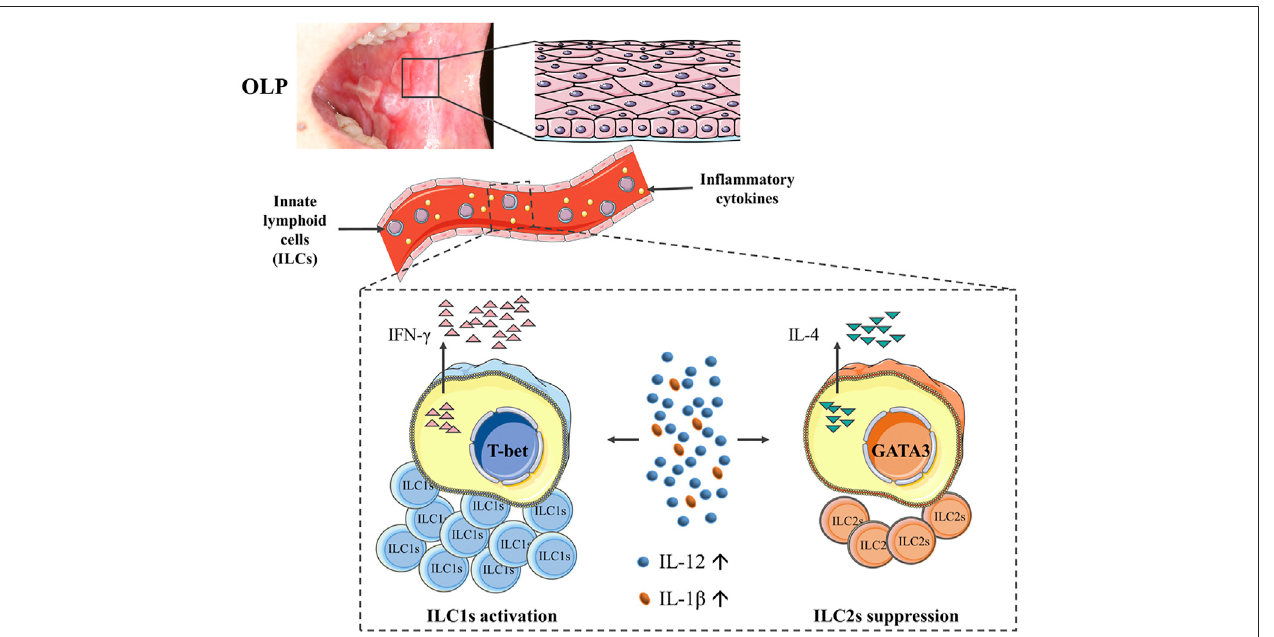
FIGURE 8 | Diagram illustrating that the phenotypes and function of circulating ILCs in OLP were altered, showing an imbalanced ILC1/ILC2 state with ILC1 activation and ILC2 suppression. Of note, elevated levels of IL-12 and IL-1 β might act as environmental cues in tipping the balance of ILC1/ILC2 in peripheral blood of OLP, thus contributing to the immune dysregulation in OLP. ILCs, innate lymphoid cells; OLP, oral lichen planus.